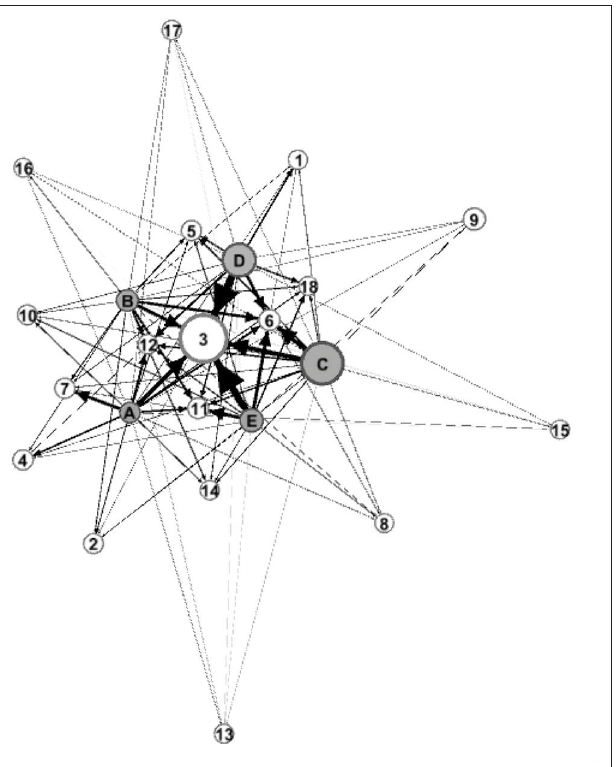
FIGURE 5 | Credit network between banks and real industry.